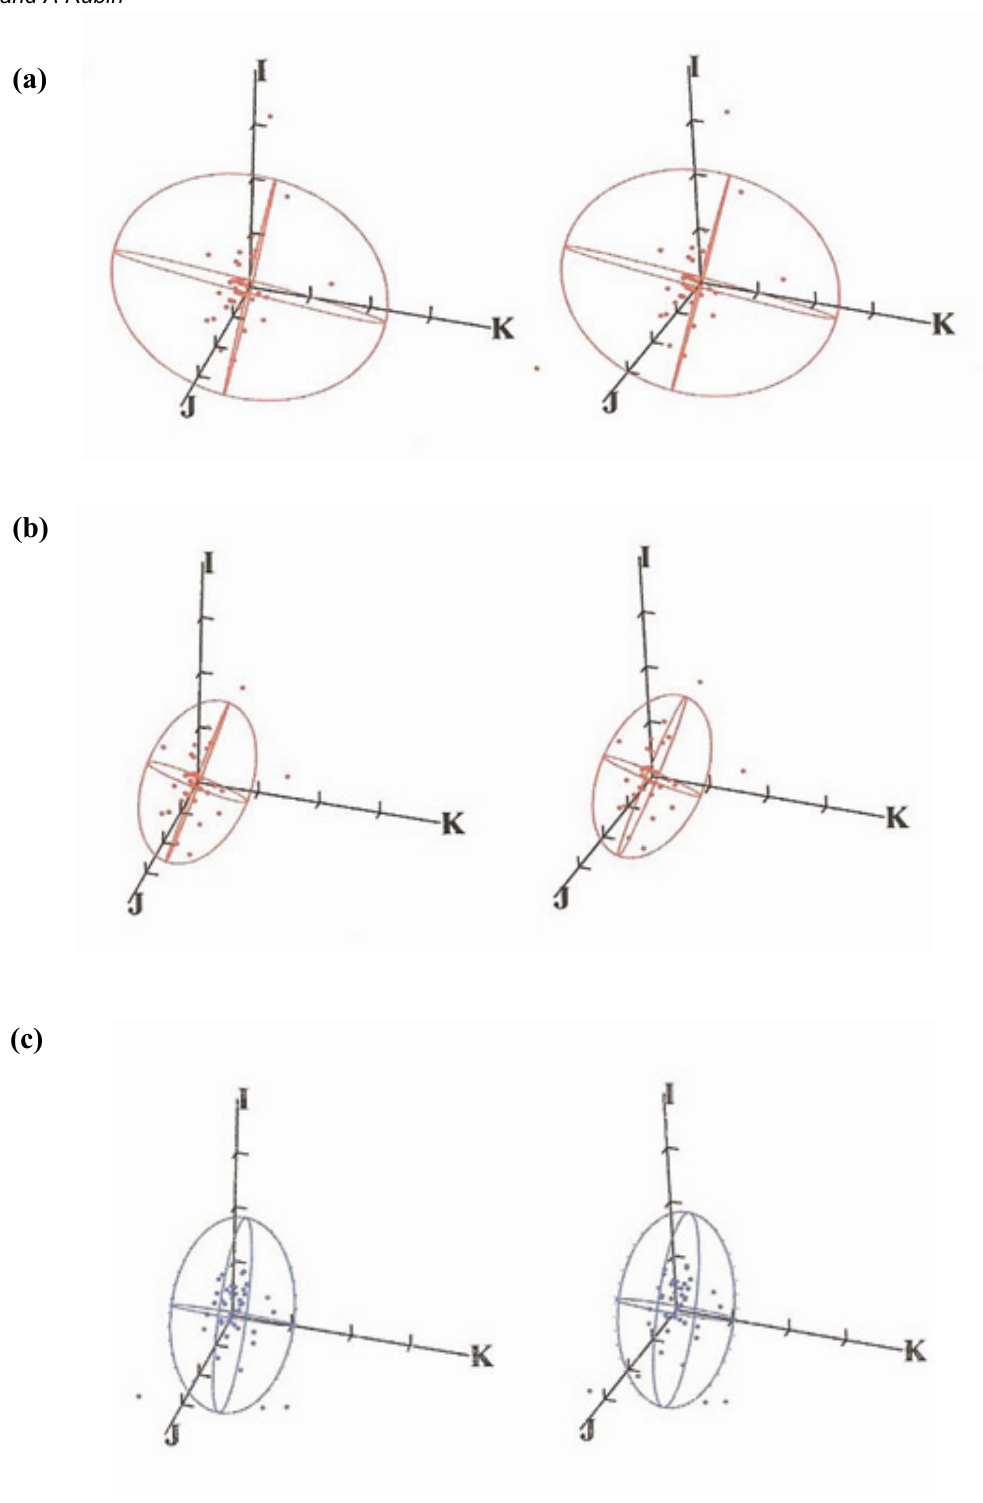
Figure 1 . Stereo-pair scatter plots for Subject 1 in symmetric power space representing autokeratometry measurements ( a ) with and without ( b ) two outliers and Pentacam measurements ( c ). The three mutually orthogonal axes represent the scalar F I , ortho-antistigmatic F J and oblique antistigmatic F K components of the powers. The J K I origin of each stereo-pair represents the applicable sample mean (see Table 1). Each dot represents one measurement of the anterior keratometry (or corneal power) and tick intervals are 0.25 I , 0.25 J and 0.25 K